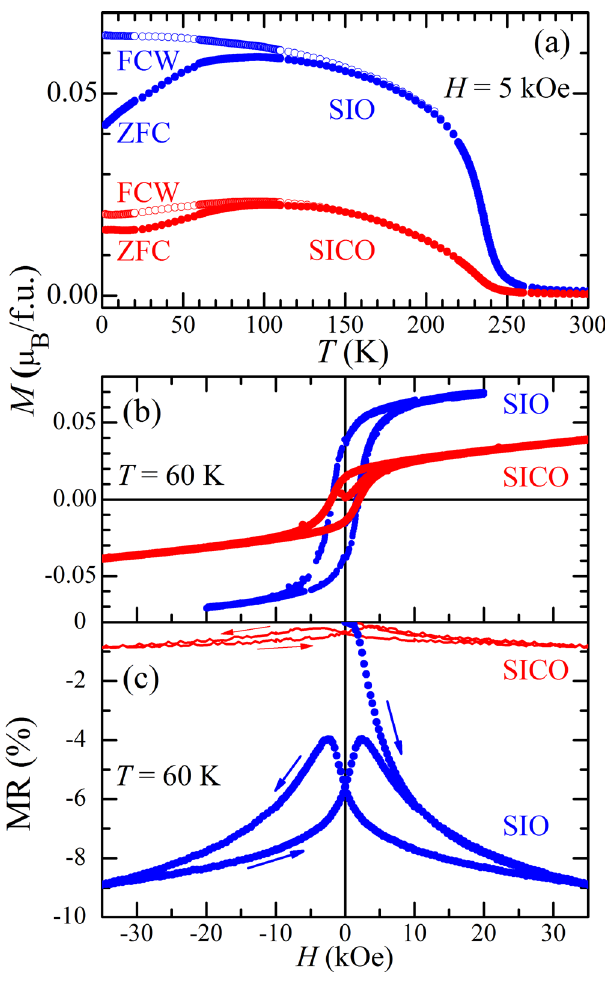
Fig. 4 Magnetization and magnetoresistance. a Temperature dependence of the magnetization M ( T ) of Sr 2 IrO 4 (SIO) and Sr 2 Ir 0.95 Co 0.05 O 4 (SICO) taken on warming with a magnetic fi eld H = 5 kOe that is applied after zero- fi eld cooling (ZFC) or fi eld cooling (FCW). H -dependence of magnetization ( b ) and magnetoresistance MR ≡ [ ρ ( H ) − ρ ( H = 0))/ ρ ( H = 0)] ( c ) for both materials at T = 60 K, where ρ ( H ) is the magnetic- fi eld dependent electrical